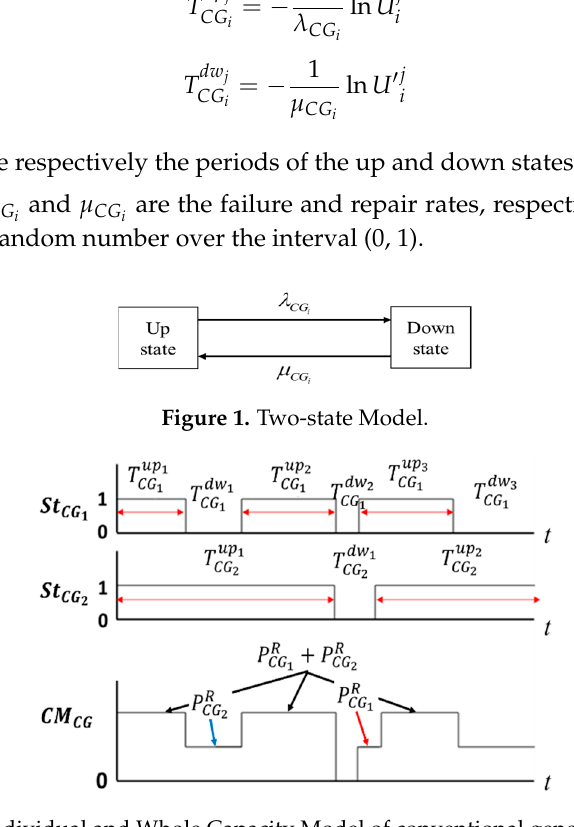
Figure 2. Individual and Whole Capacity Model of conventional generators (CGs).